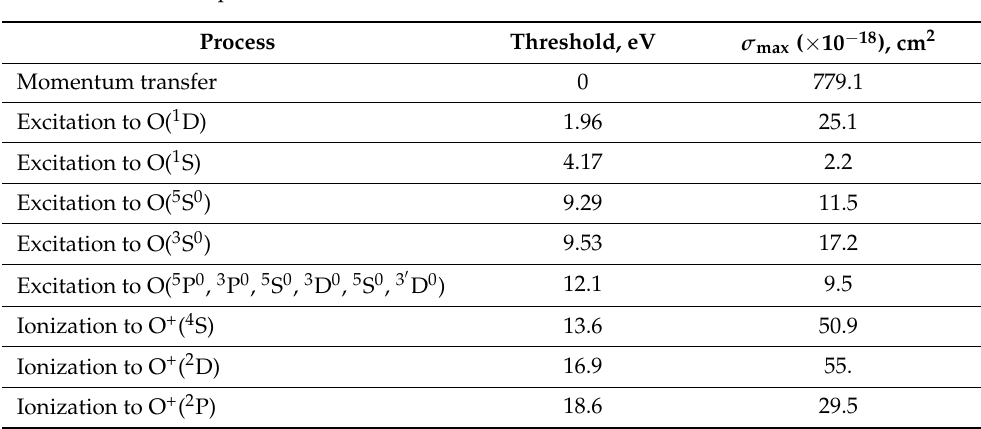
Table A3. Electron impact on